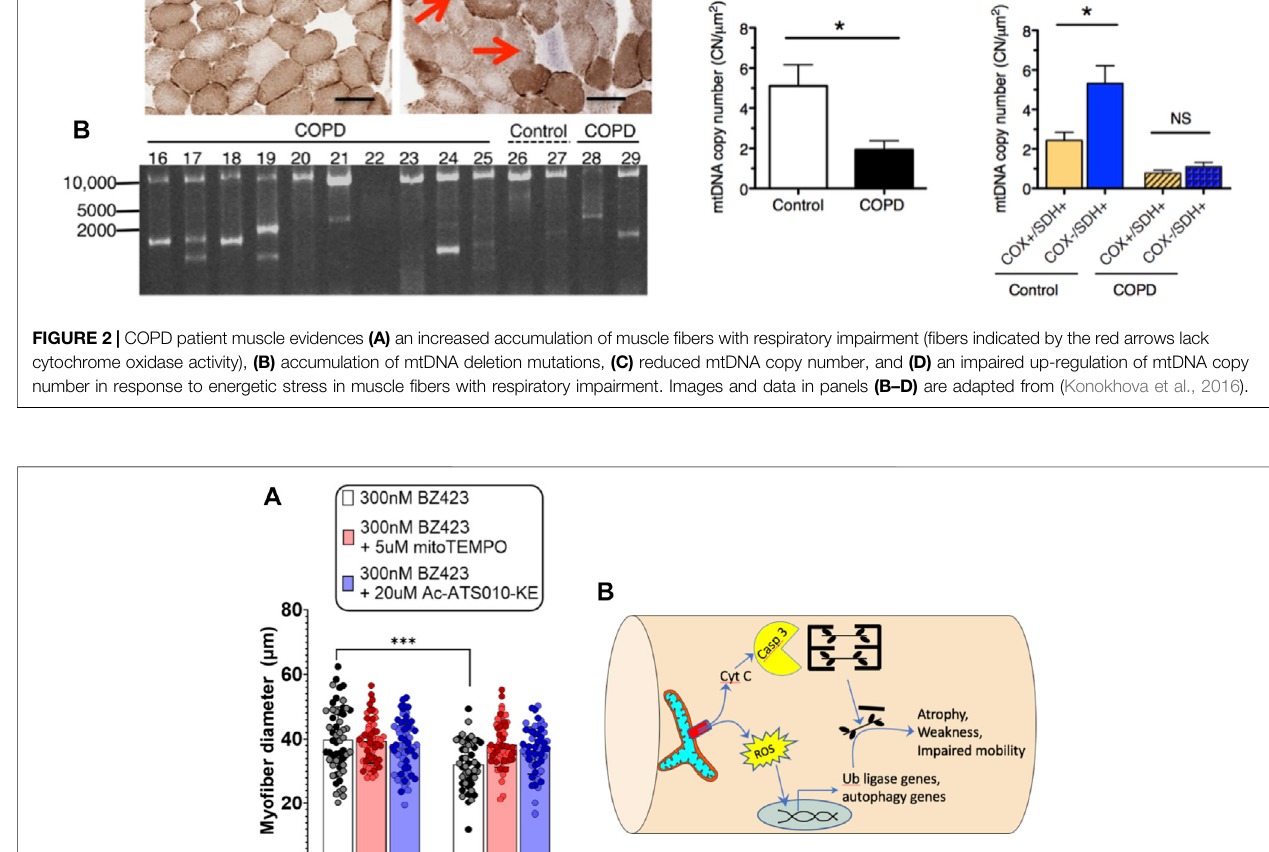
Frontiers in Physiology |